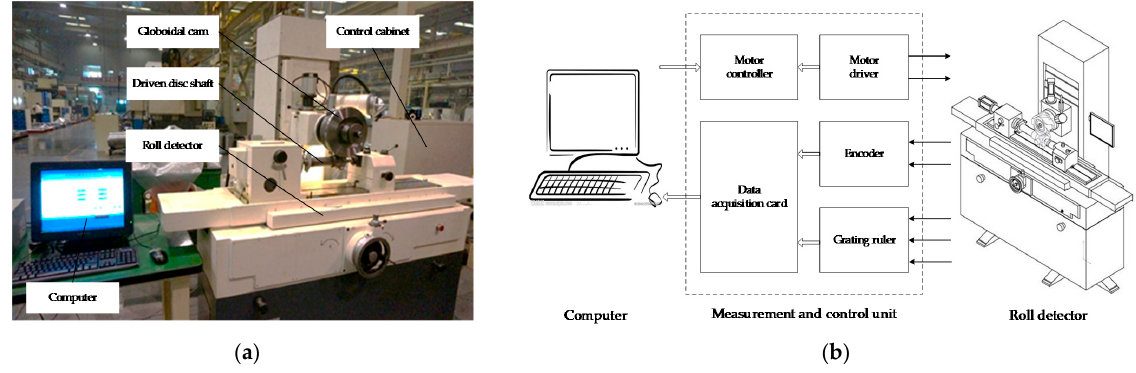
Figure 7. Globoidal cam Precision Inspection System. ( a ) Globoidal cam transmission precision de- tection device; ( b ) Schematic of precision detection system for globoidal cam.